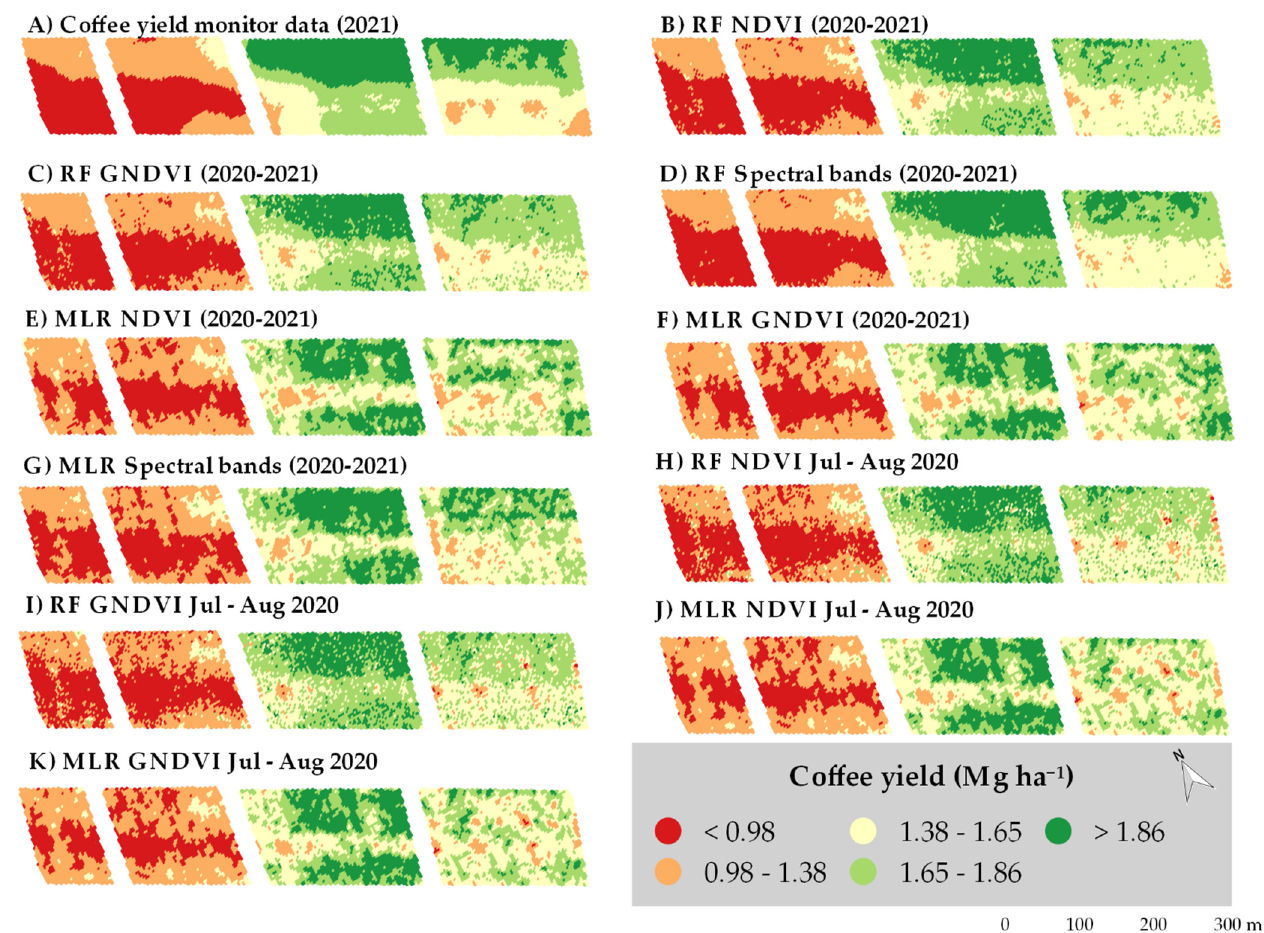
Figure 6. Coffee yield (Mg ha − 1 ) maps generate for harvest 2 (2020–2021) from ( A ) Coffee monitor data/2021; ( B ) RF regression model based on spectral bands/2020/2021, ( C ) RF regression based on NDVI/2020/2021, ( D ) RF regression based on GNDVI/2020/2021, ( E ) MLR based on spectral bands/2019/2020, ( F ) MLR based on NDVI/2020/2021, ( G ) MLR based on GNDVI/2020/2021, ( H ) RF regression based on NDVI obtained in July (jul) and August (ago)/2020, ( I ) RF regression based on GNDVI obtained from July and August/2020, ( J ) MLR based on NDVI obtained from July